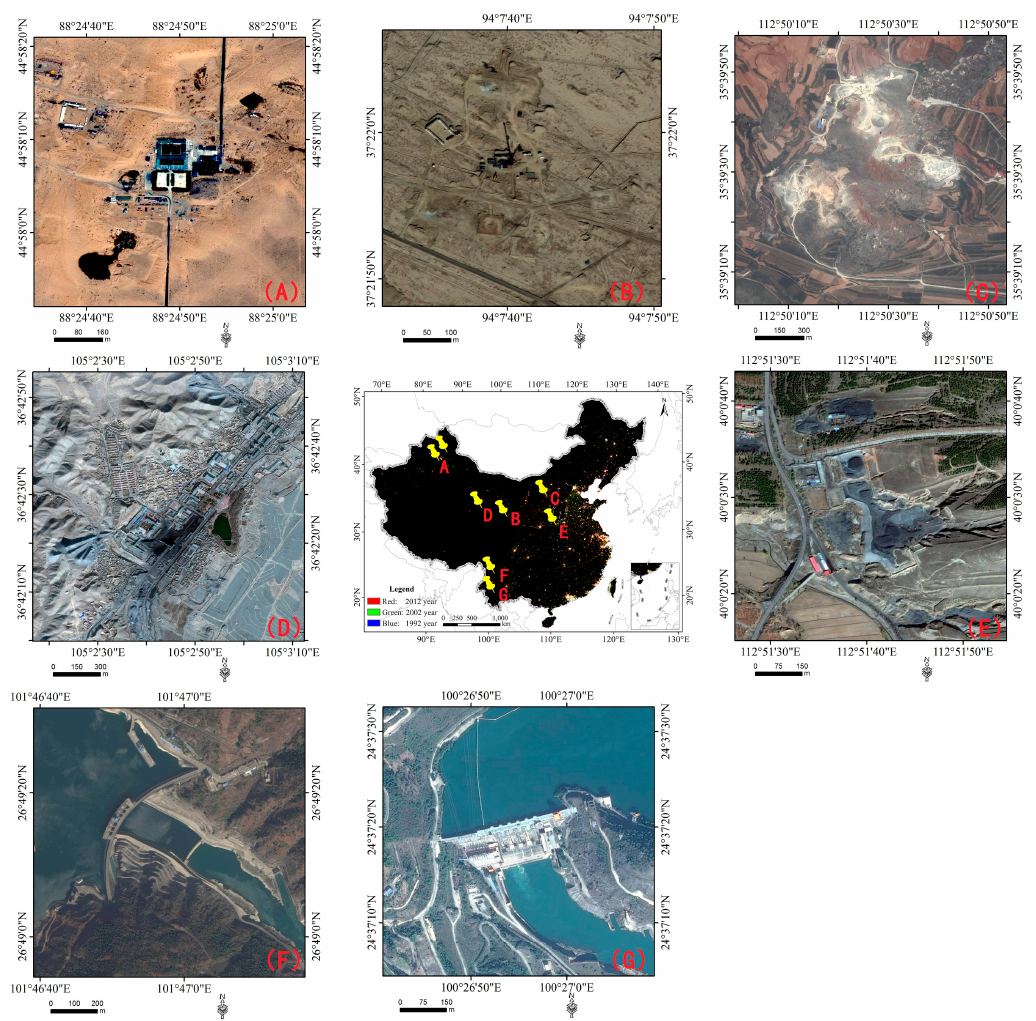
Figure 7. Validation of the nighttime light pollution decline regions (( A , B ) represent oil mining abandoned facilities; ( C – E ) represent coal mining abandoned facilities; and ( F , G ) represent dam construction facilities).